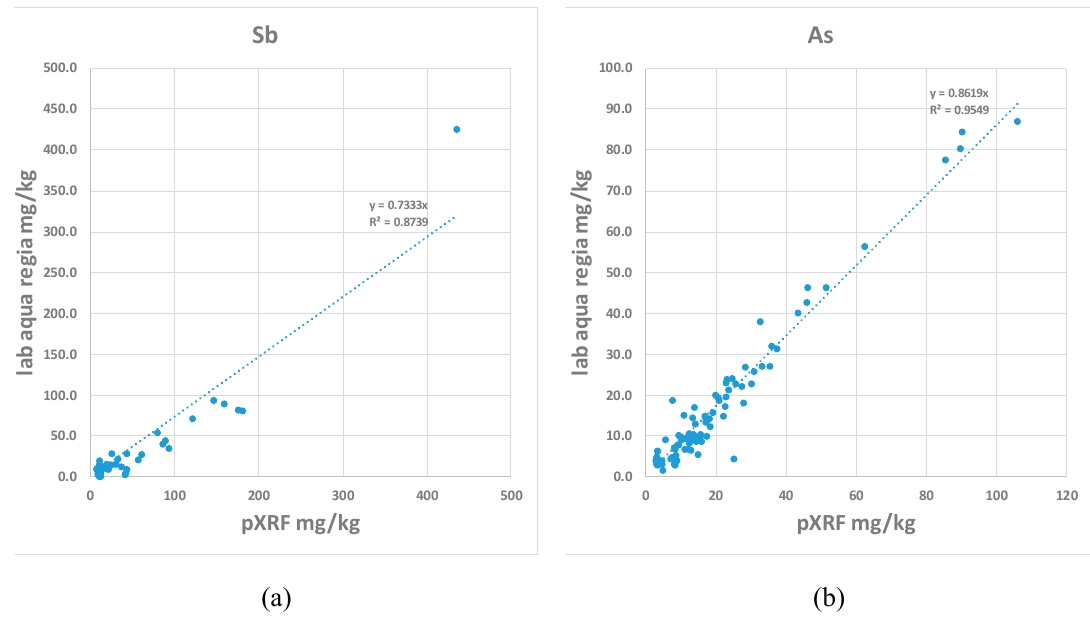
Figure 19. pXRF measurements vs. ICP/AES analyses, Ah horizon soils, in mg/kg: ( a ) Sb; ( b ) As.